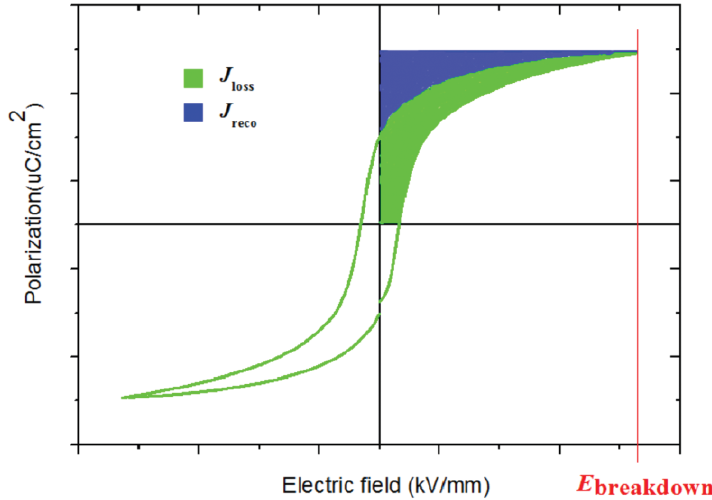
Figure 2. Graphical representation of a P – E loop used for energy-storage calculations. Reproduced with permission from Ref. [18]. Copyright 2017, Wiley – VCH.